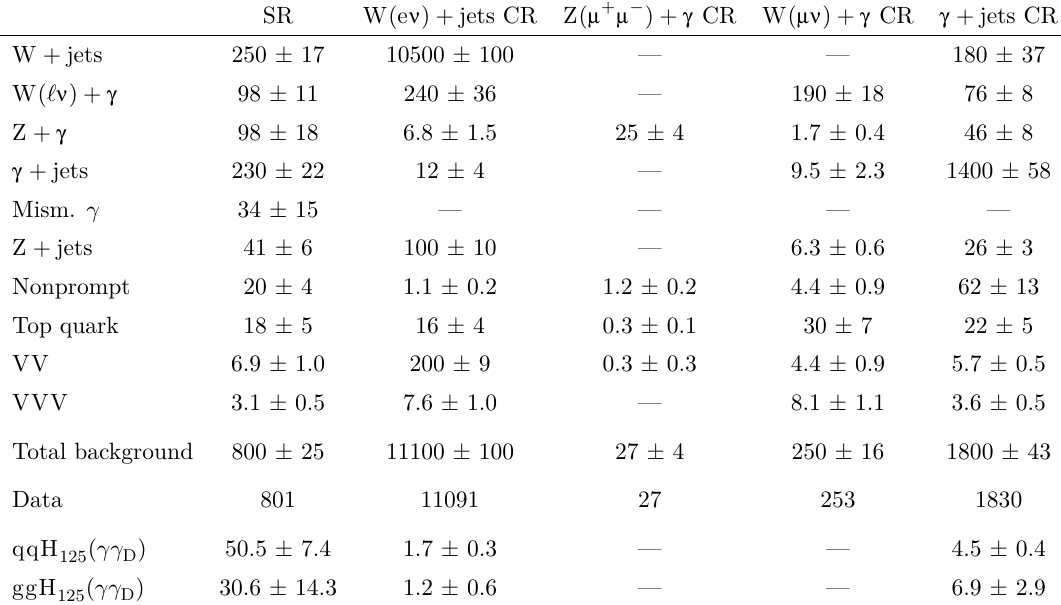
Table 4 . Data, expected backgrounds, and estimated signal in the different regions. The expected background yields are shown with their best-fit normalizations from the simultaneous fit assuming background-only in the different regions. The combination of the statistical and systematic uncer- tainties is shown. The illustrative signal yield assumes a production cross section of 0 . 05 σ data-taking periods and trigger paths are combined together for each region.